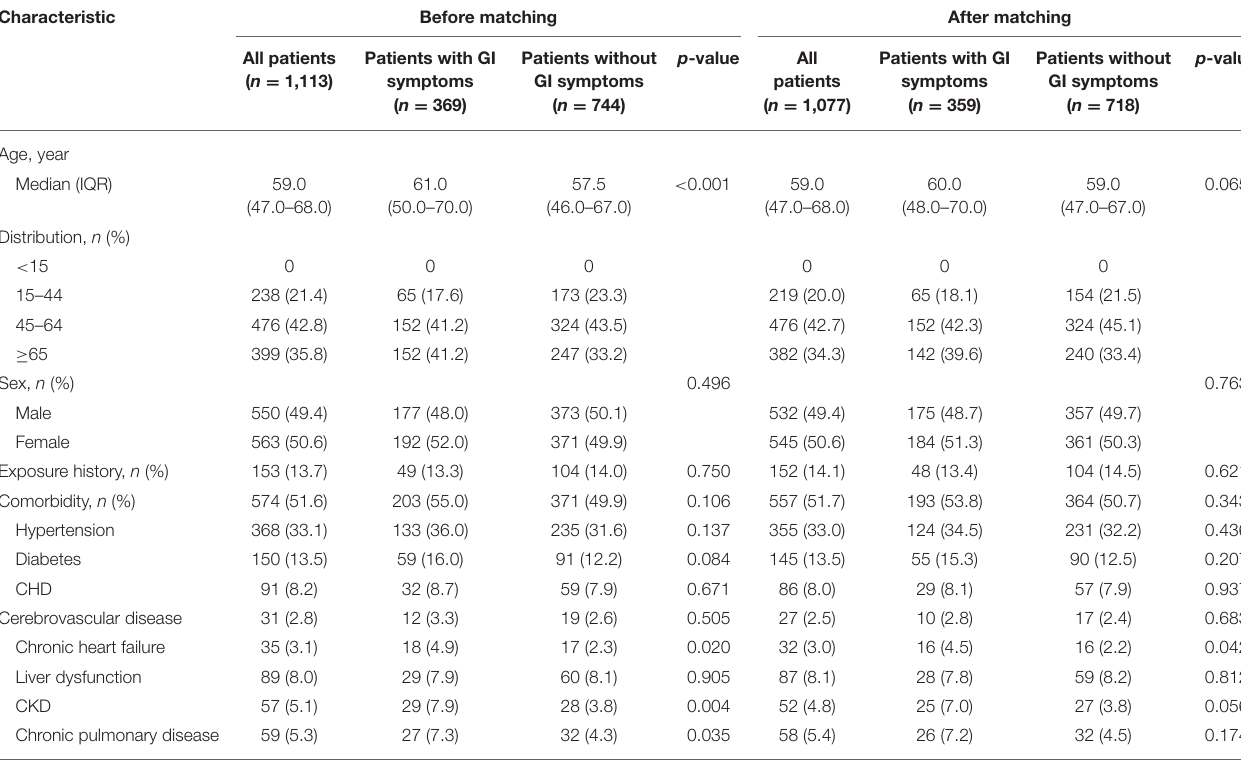
TABLE 1 | Baseline characteristics of patients with COVID-19 before and after propensity score